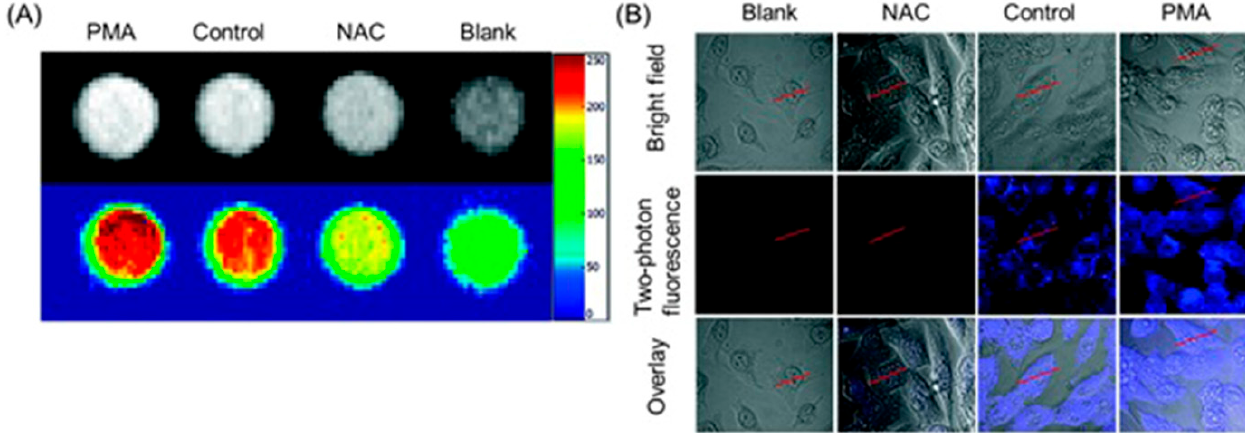
Figure 27. In vitro studies of MCF-7 cells incubated with TP-CQDs@MnO 2 (375.0 μ g mL –1 ). ( A ) T 1 -weighted MRI images of MCF-7 cells: PMA = cells incubated with TP-CQDs@MnO 2 and phorbol-12-myristate-13-acetate; control = cells incubated with TP-CQDs@MnO 2 ; NAC = cells incubated with TP-CQDs@MnO 2 and N-acetyl-L-cystein (NAC); and blank = cells in buffer without adding TP-CQDs@MnO 2 . PMA is a hydrogen peroxide stimulant and NAC is a hydrogen peroxide scavenger. The brightest fluorescence of the two-photon images was observed with cells incubated with PMA and the weakest fluorescence was observed with cells incubated with NAC. The bright T 1 -weighted image of the control sample compared to the blank indicates that the TP-CQDs@MnO 2 probe selectively visualizes endogenous hydrogen peroxide in MCF-7 cells. ( B ) Two-photon fluorescence images of MCF-7 cells incubated with TP-CQDs@MnO 2 (375.0 μ g mL –1 ). Blank = cells in buffer without adding TP-CQDs@MnO 2 ; NAC = cells incubated with TP-CQDs@MnO 2 and NAC; control = cells incubated with TP-CQDs@MnO 2 ; PMA = cells incubated with TP-CQDs@MnO 2 and PMA. Scale bars represent 20.0 μ m. The fluorescence images show that the nanoprobe responds to endogenous hydrogen peroxide in a tumor microenvironment using two-photon fluorescence. Adapted with permission of the Royal Society of Chemistry, from Two-photon fluorescence and MR bio-imaging of endogenous H 2 O 2 in the tumor microenvironment using a dual-mode nanoprobe. Zhong, H.; Yu, S.; Li, B.; He, K.; Li, D.; Wang, X.; Wu, Y.-X. 57 , 51, 2021 ; permission conveyed through Copyright Clearance Center, Inc. [307].